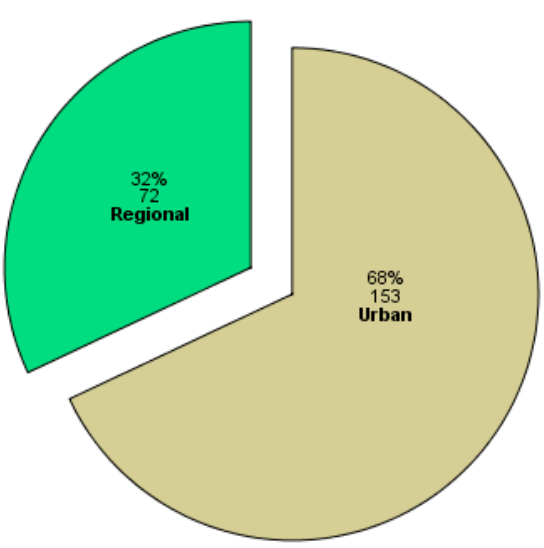
Figure 3. Distribution in Victoria by region.